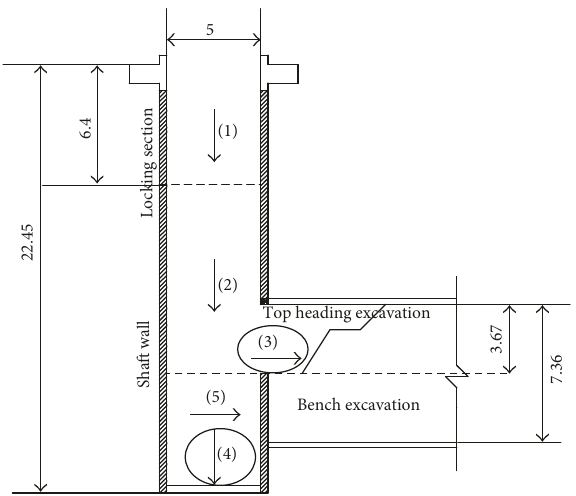
Figure 3: Construction sequence of Method 2 (unit: mm).